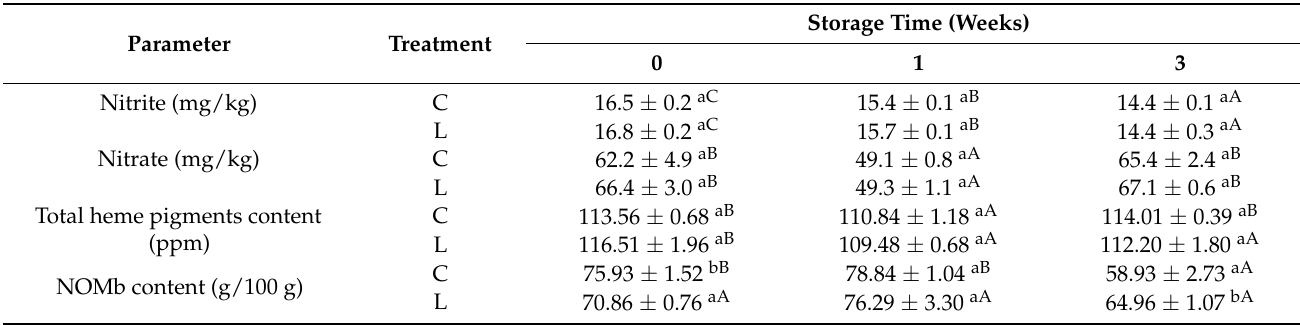
C—control treatment with MSPM without a bacteria strain, L—treatment with MSPM and the bacteria L. plantarum SCH1 (10 7 cfu/g). Various small letters (a–b) in the same column indicate significant differences between treatments ( p < 0.05). Various capital letters (A–C) in the same line indicate significant differences while being stored ( p <